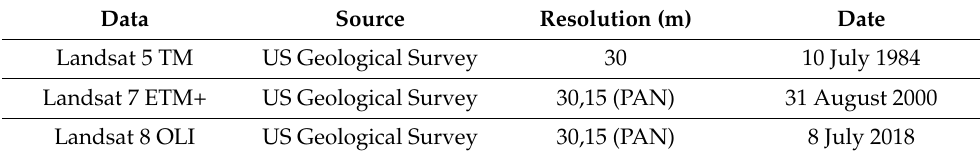
Table 1. Characteristics of remote sensing data.